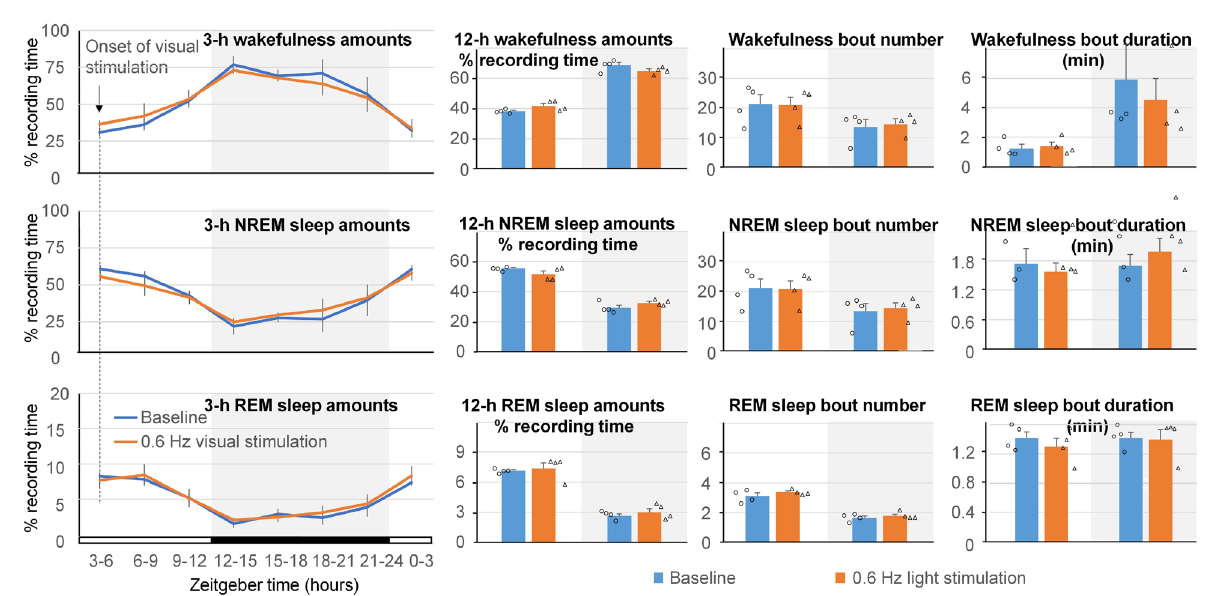
Figure 3. Effect of visual stimulation with 400-ms 620-nm light pulses at 0.6 Hz on sleep pattern. No significant differences in the amounts of wakefulness, NREM sleep and REM sleep calculated in either 3-h or 12-h intervals between the baseline and stimulation day were found. Number and duration of sleep bouts also did not change. White background indicates light periods, and grey background indicates dark